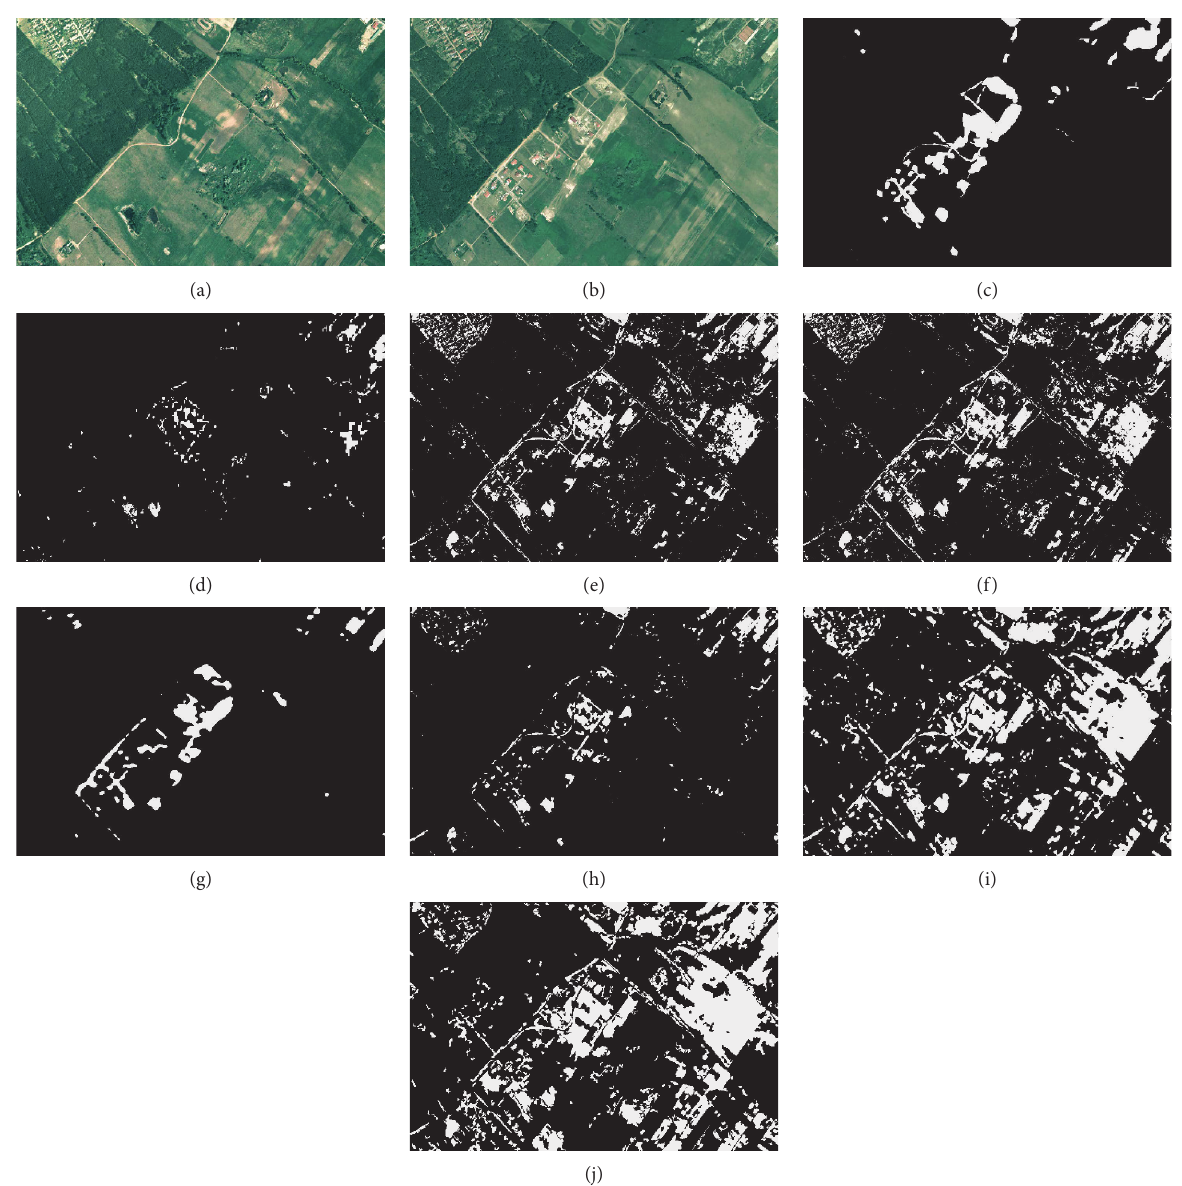
Figure 2: Visual comparison of change detection results in the first group of experiments. (a) Image 1. (b) Image 2. (c) Reference